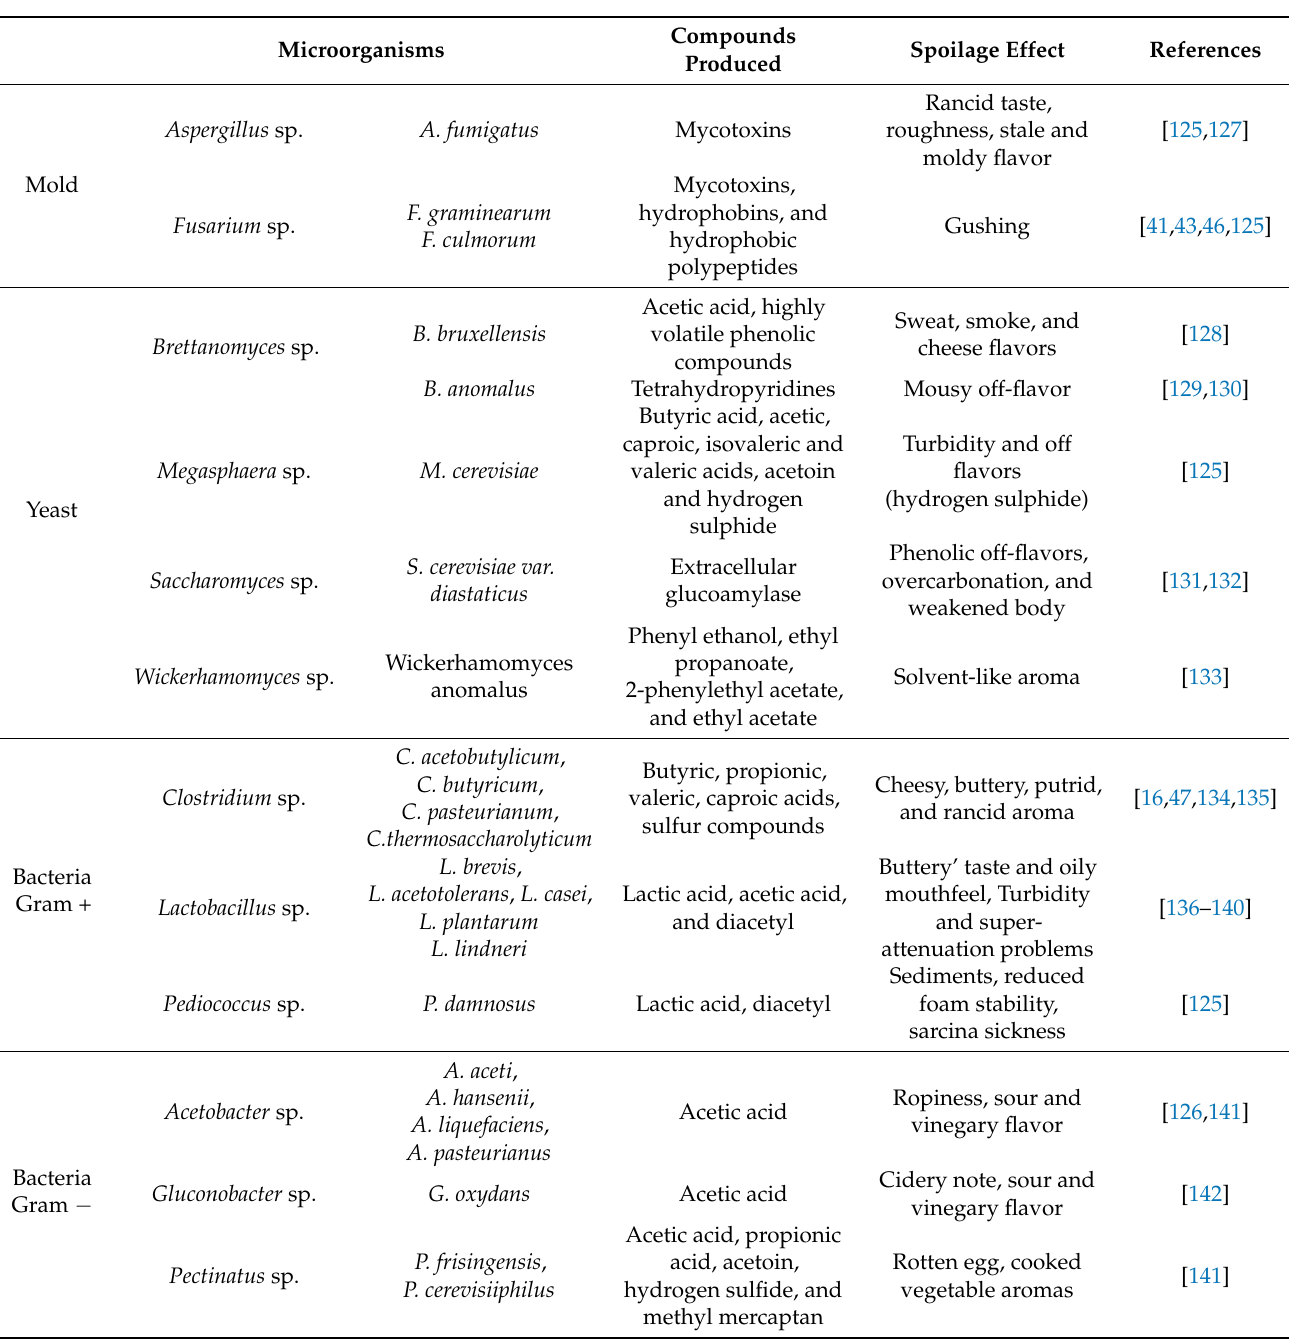
Table 2. Most common spoilage microorganisms in